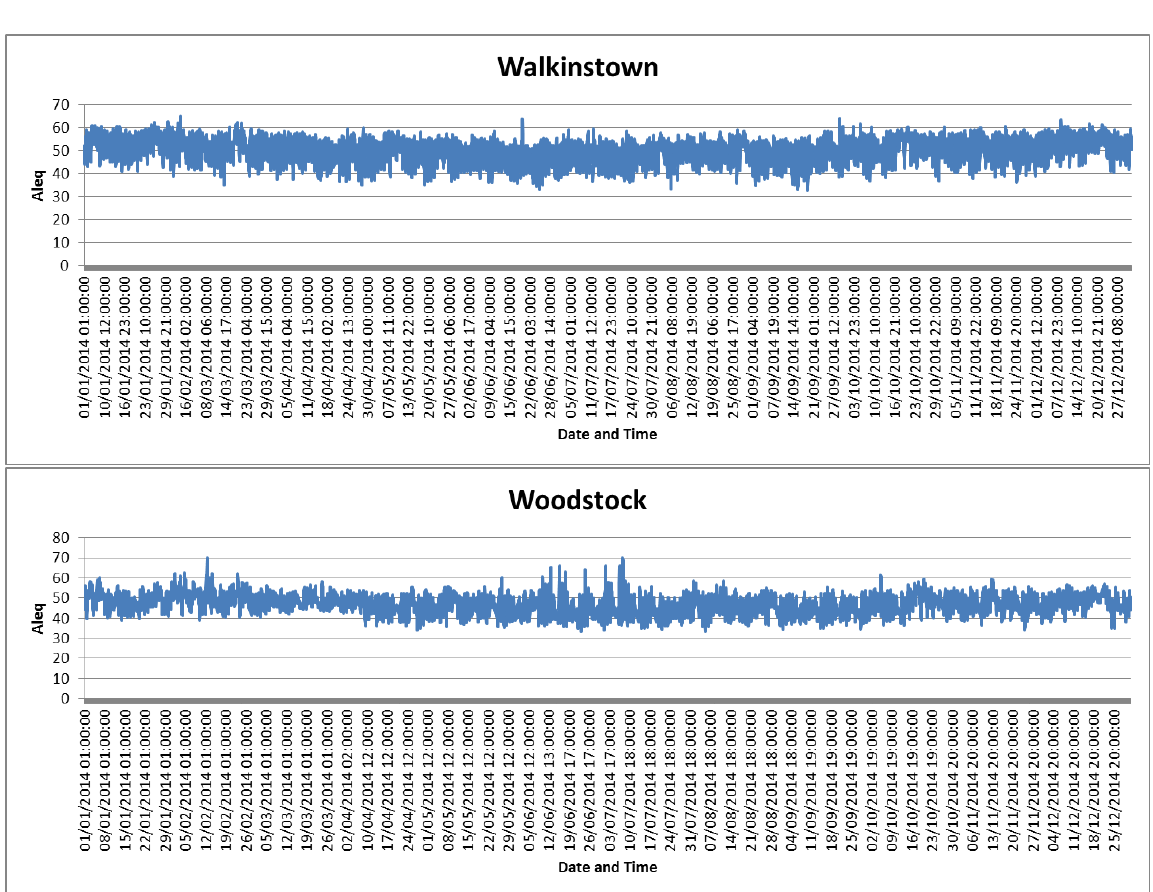
Supplementary Figure 3: AL eq at hourly